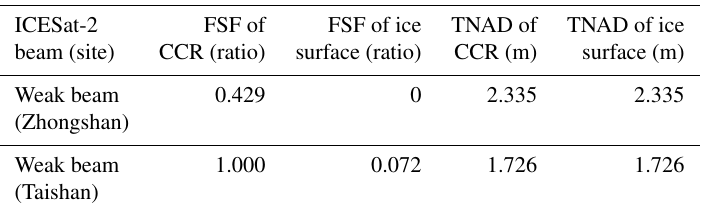
Table 4. The full saturation fraction (FSF) and total neutral atmospheric delay (TNAD) of the illuminated CCRs near Zhongshan Station and Taishan Station. ICESat-2 FSF of FSF of ice TNAD of TNAD of ice beam (site) CCR